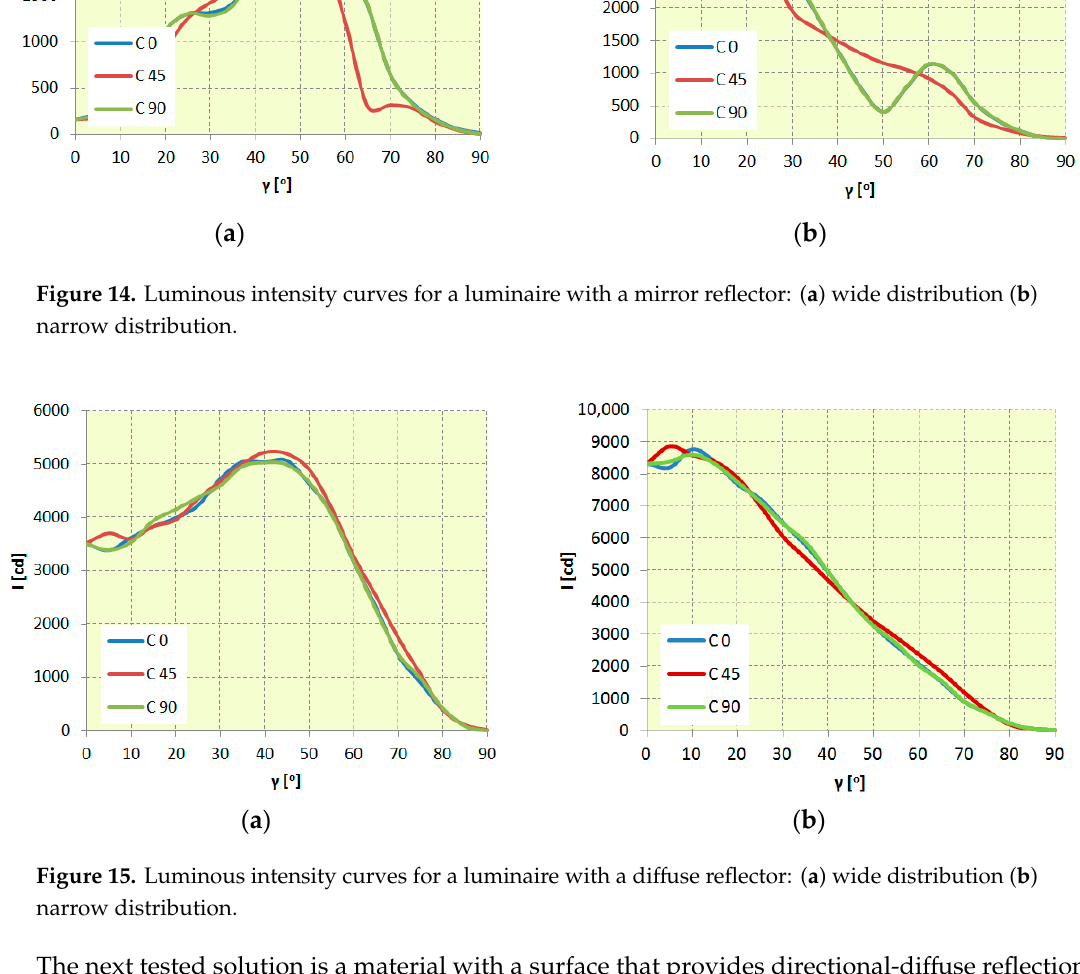
Figure 14. Luminous intensity curves for a luminaire with a mirror reflector: ( a ) wide distribution ( b ) narrow distribution.